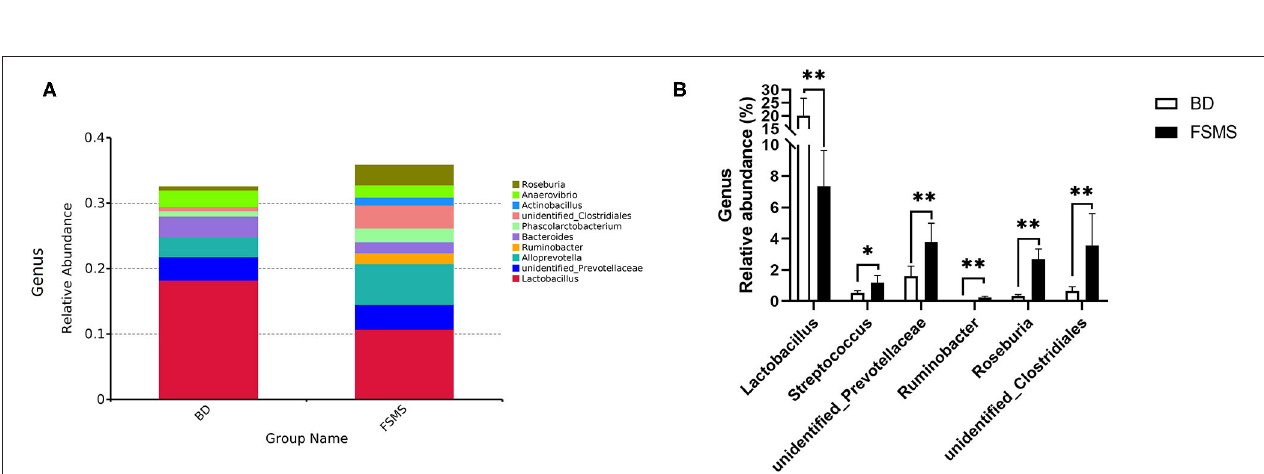
Frontiers in Veterinary Science |